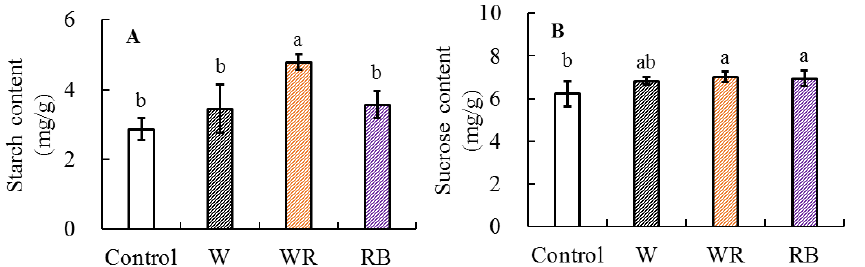
Figure 4. The impacts of supplementary white LEDs, white plus red LEDs, and red plus blue LEDs on the stem firmness of the greenhouse-grown tomato seedlings, and tomato seedlings grown under sunlight only were regarded as the control. Different letters on top of the bars denote significant differences according to the LSD test ( p < 0.05). Error bars represent the mean ± SD.